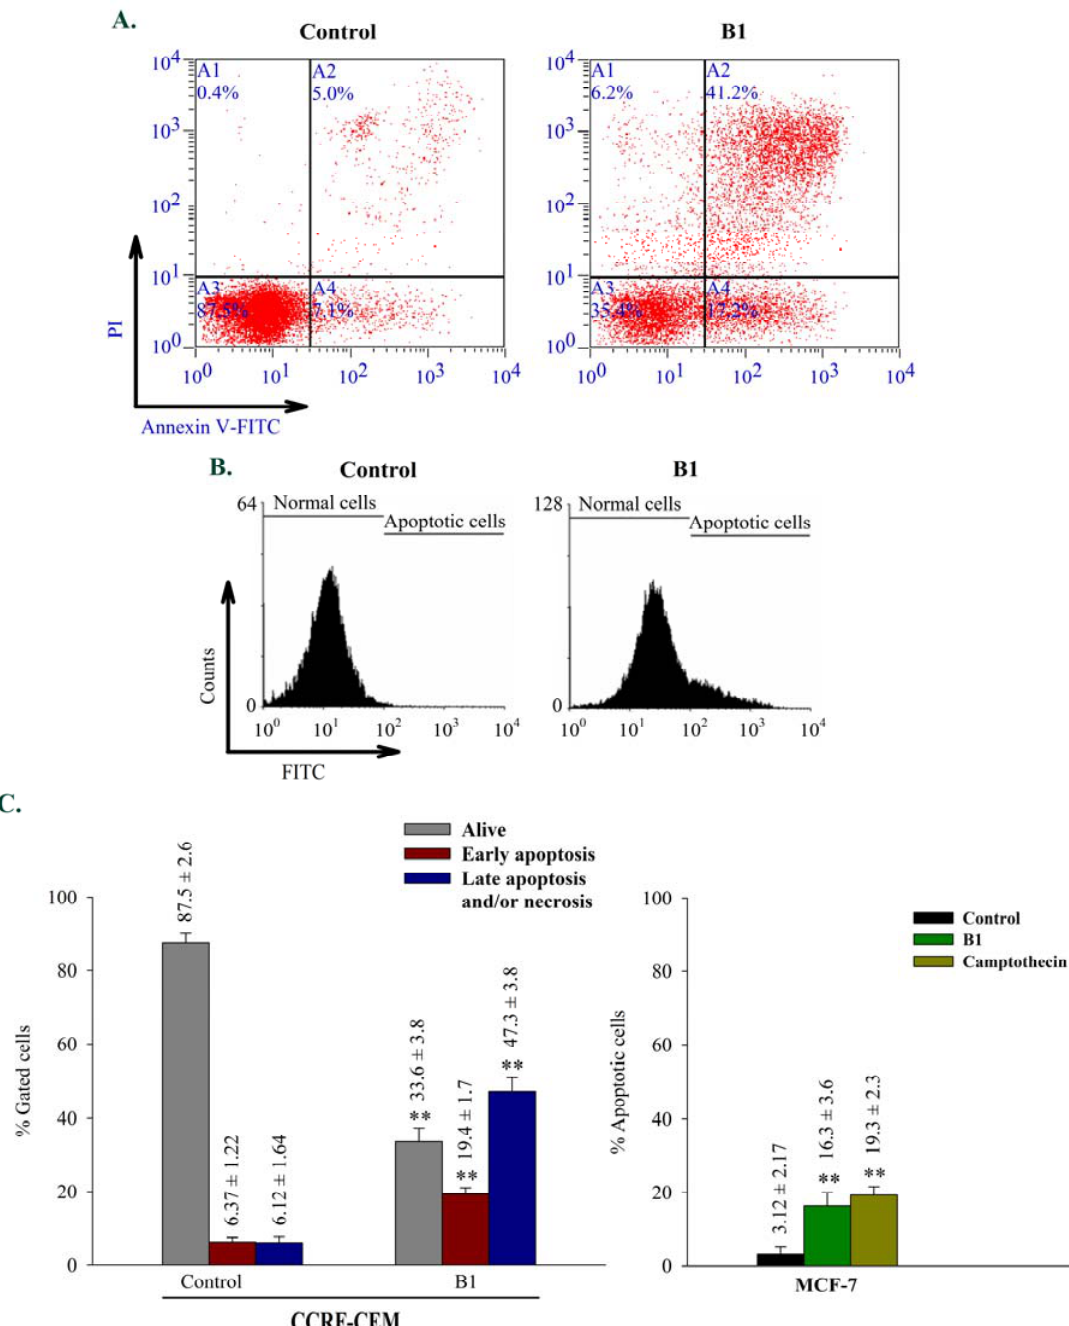
Figure 5. Apoptotic effects of compound B1 and camptothecin at 10 or 25 μ M on CCRF- CEM and MCF-7 cells for 24 and 48 h, respectively. ( A ) Apoptotic effects of compound B1 on CCRF-CEM were assessed by Flow Cytometry analysis after staining with Annexin V-FITC. Annexin V staining is represented on the x-axis and PI staining is represented on the y-axis. The representative results of three independent experiments are shown; ( B ) Apoptotic effects of compound B1 were assessed by Flow Cytometry analysis using the Apo-Direct kit, based on the TUNEL assay; ( C ) Percentage of apoptotic and or necrotic cells after compound B1 or camptothecin treatment were calculated from the flow cytometry results. Each bar represents the mean of three independent experiments and the error bars indicate standard deviation. ** p < 0.01 with respect to the